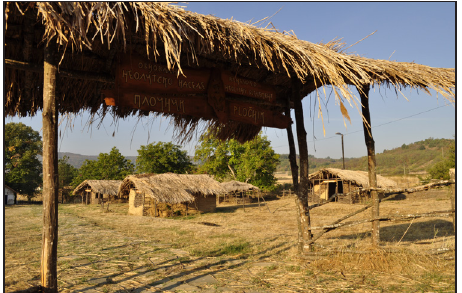
Figure 9: Plo č nik archeopark, Serbia (Photo: Miljana